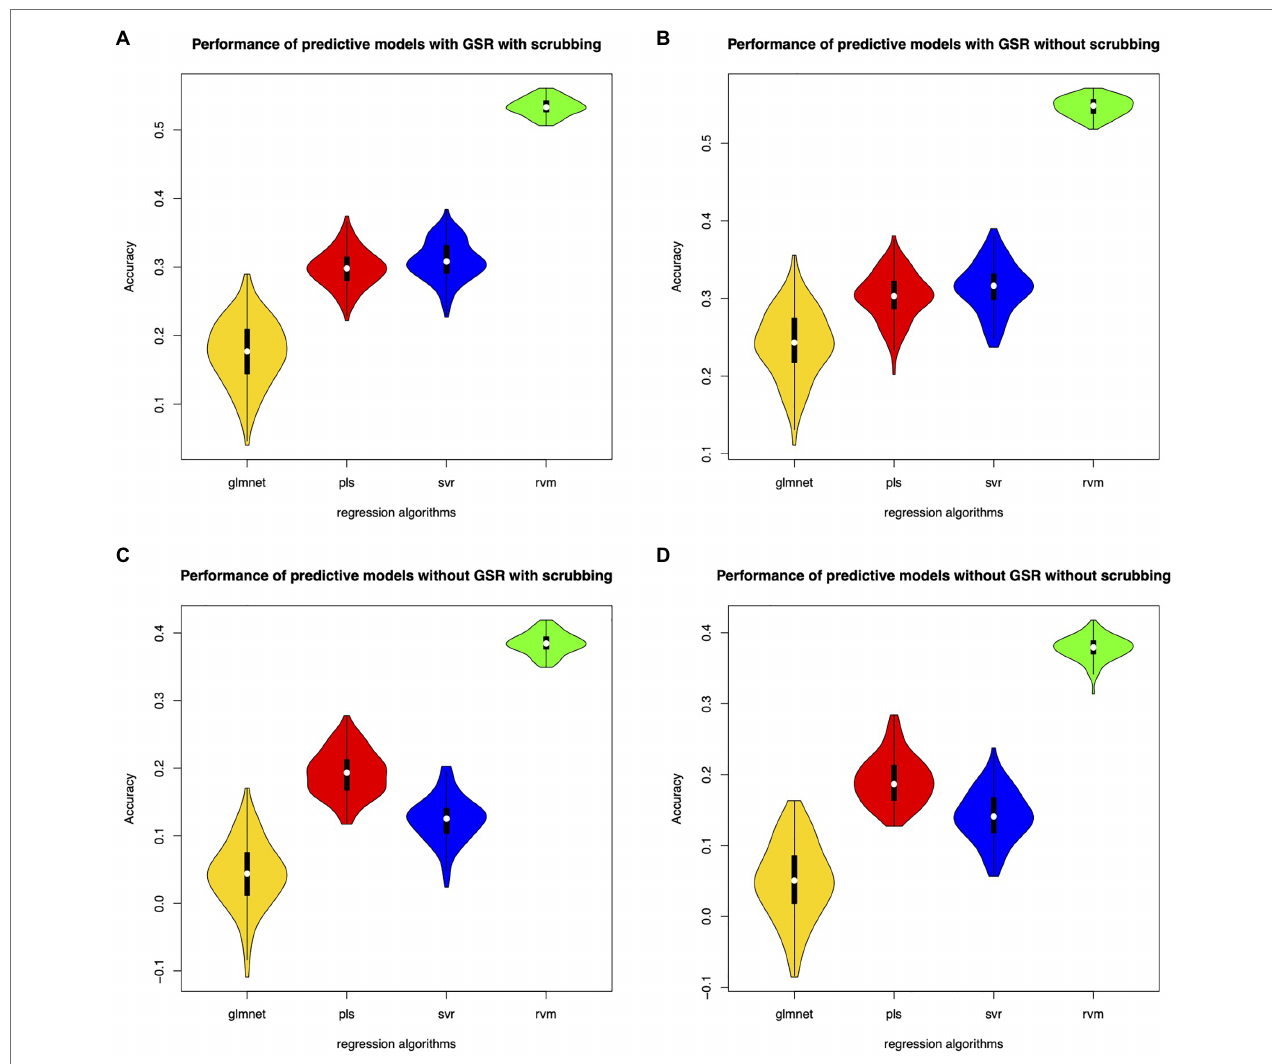
FIGURE 5 | Performance of the predictive models with fine-tuned parameters. (A) denotes performance of the predictive models with GSR and scrubbing. (B) denotes performance of the predictive models with GSR and without scrubbing. (C) denotes performance of the predictive models without GSR and with scrubbing. (D) denotes performance of the predictive models without GSR and